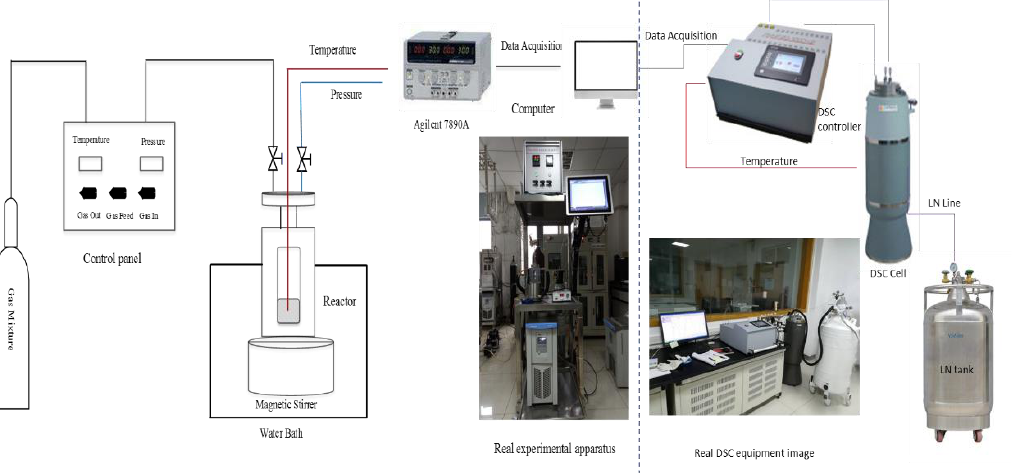
Figure 1. Schematic diagram of the experimental equipment.